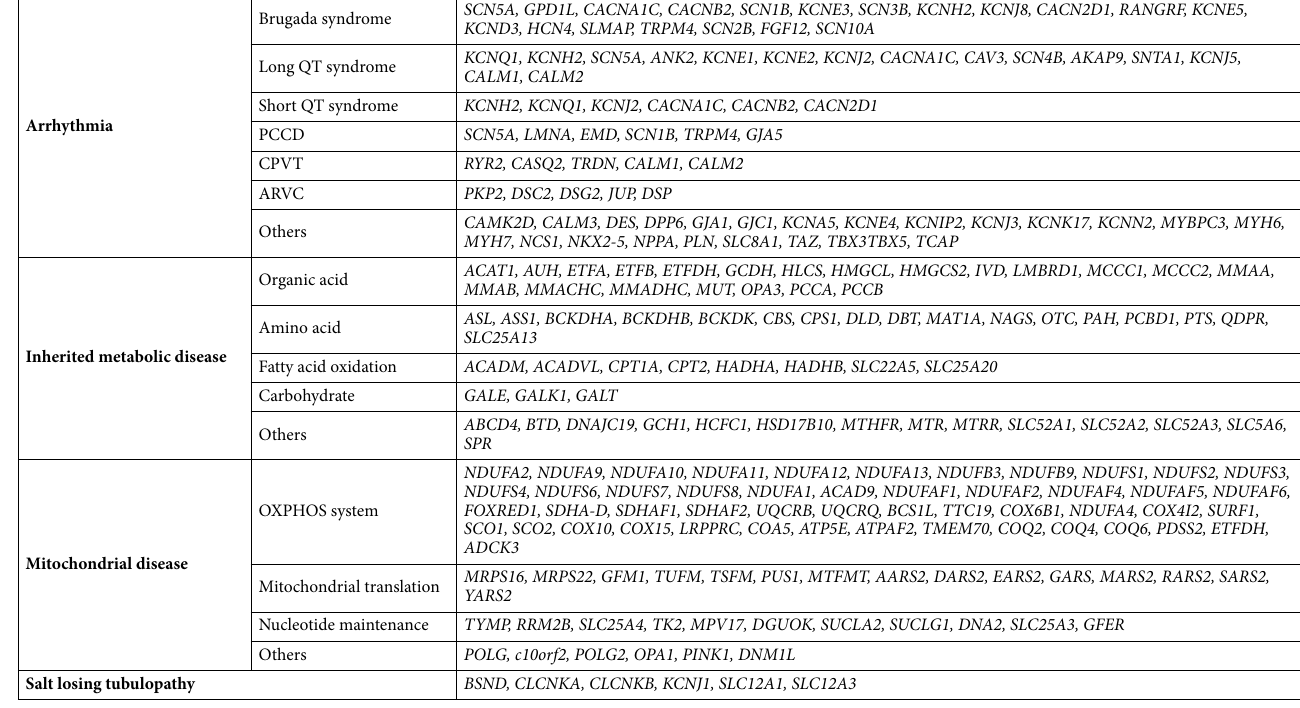
Table 2. Arrhythmia-, inherited metabolic disease-, mitochondrial disease-, and salt-losing tubulopathy- related genes investigated in this study. PCCD: progressive cardiac conduction disturbance, CPVT: catecholaminergic polymorphic ventricular tachycardia, ARVC: arrhythmogenic right ventricular cardiomyopathy, OXPHOS: oxidative